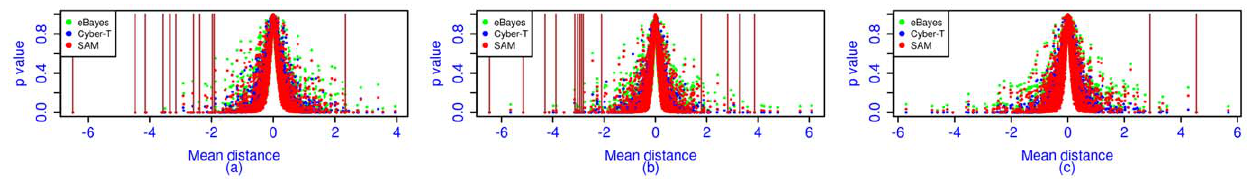
Figure 4. Significantly differential metabolites identified between Col-0 and sid2 leaves responding to infection with P.syringae at 6 hpi, 10 hpi and 16 hpi. The horizontal axes represent the mean distance between Col-0 abundance and sid2 abundance. The vertical axes represent p values. Each dot represents one metabolite. Each vertical line represents a significantly differential metabolite. (a) - top: Significantly differential metabolites between Col-0 and sid2 at 6 hpi. (b) - middle: Significantly differential metabolites between Col-0 and sid2 at 10 hpi. (c) - bottom: Significantly differential metabolites between Col-0 and sid2 at 16 hpi.